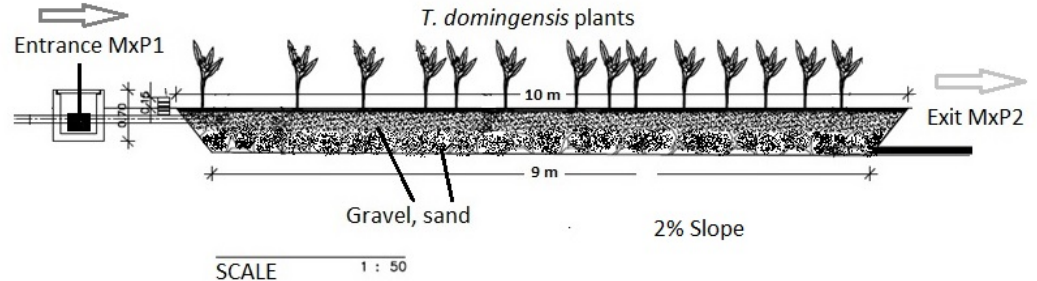
Fig. 2: Cross section of the constructed wetland’s design